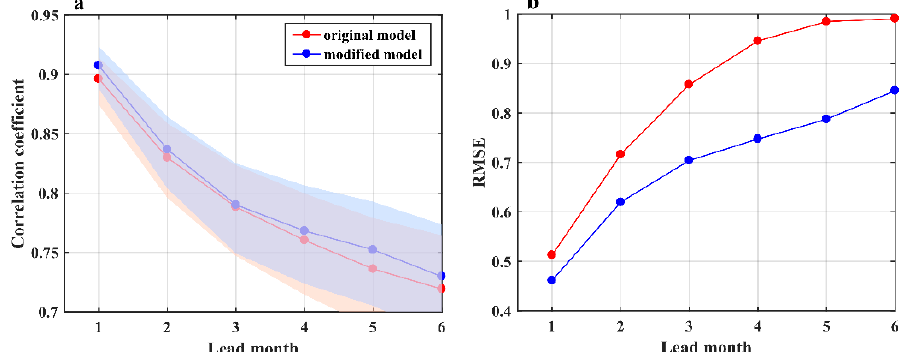
Figure 2. The ACC ( a ) with the shaded area indicating the 95% confidence interval and RMSE ( b ) of the Niño 3.4 index between the observation and the prediction for 1982–2013. The red and blue lines represent the observation and predicted results of original and modified FIO − ESM − CPS for 1 − to 6 − month lead times (unit: